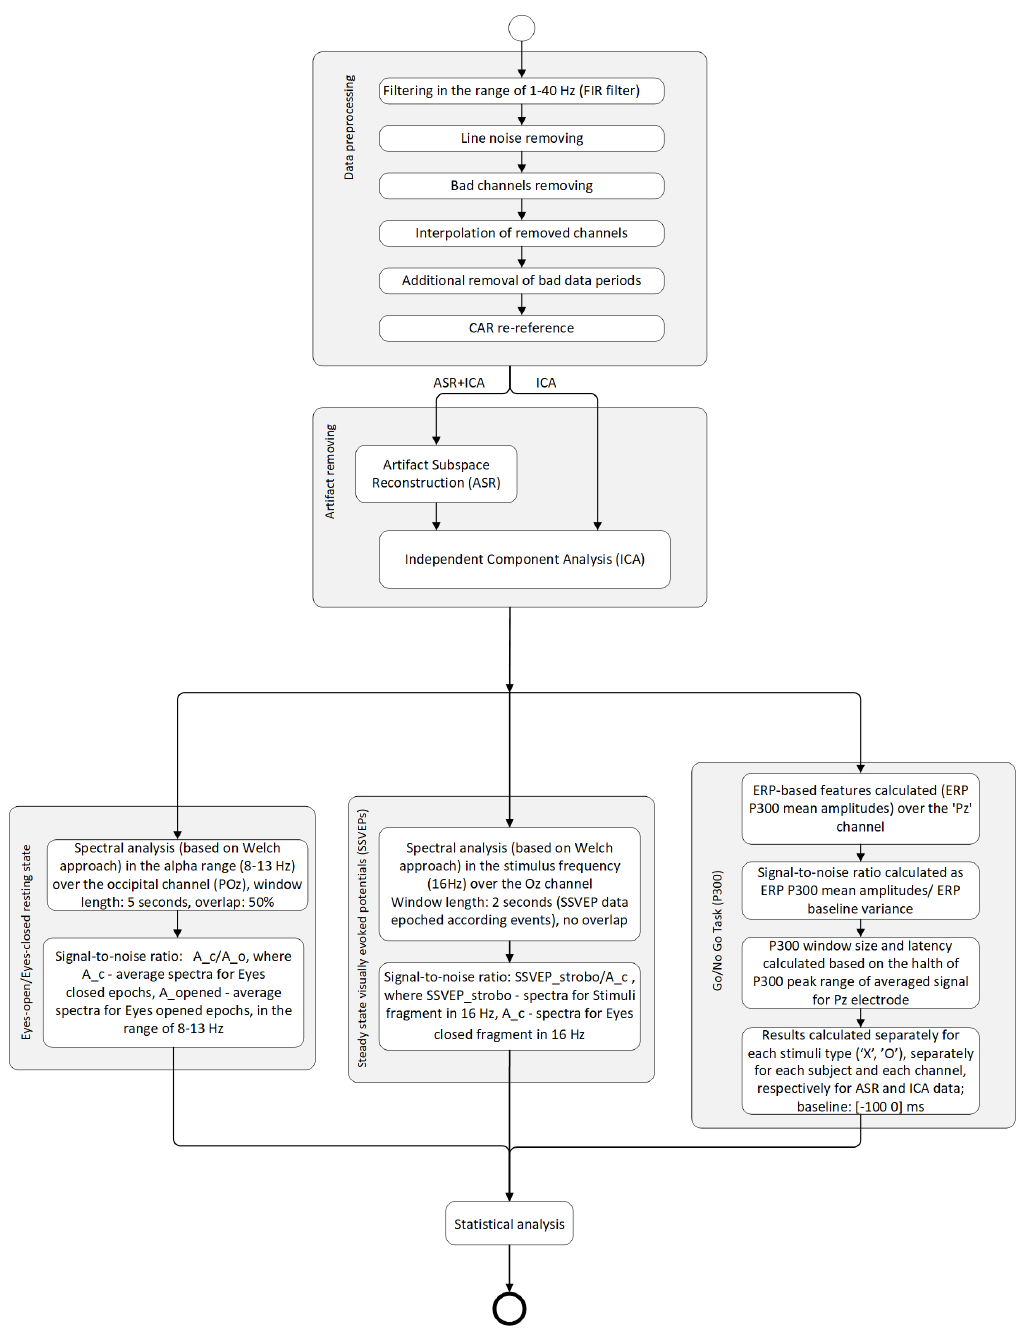
Figure 2. Data analysis procedure.